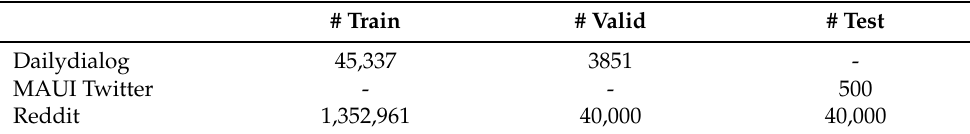
Table 2. Simple statistics on the data sets for response weight and response generation. # Train #